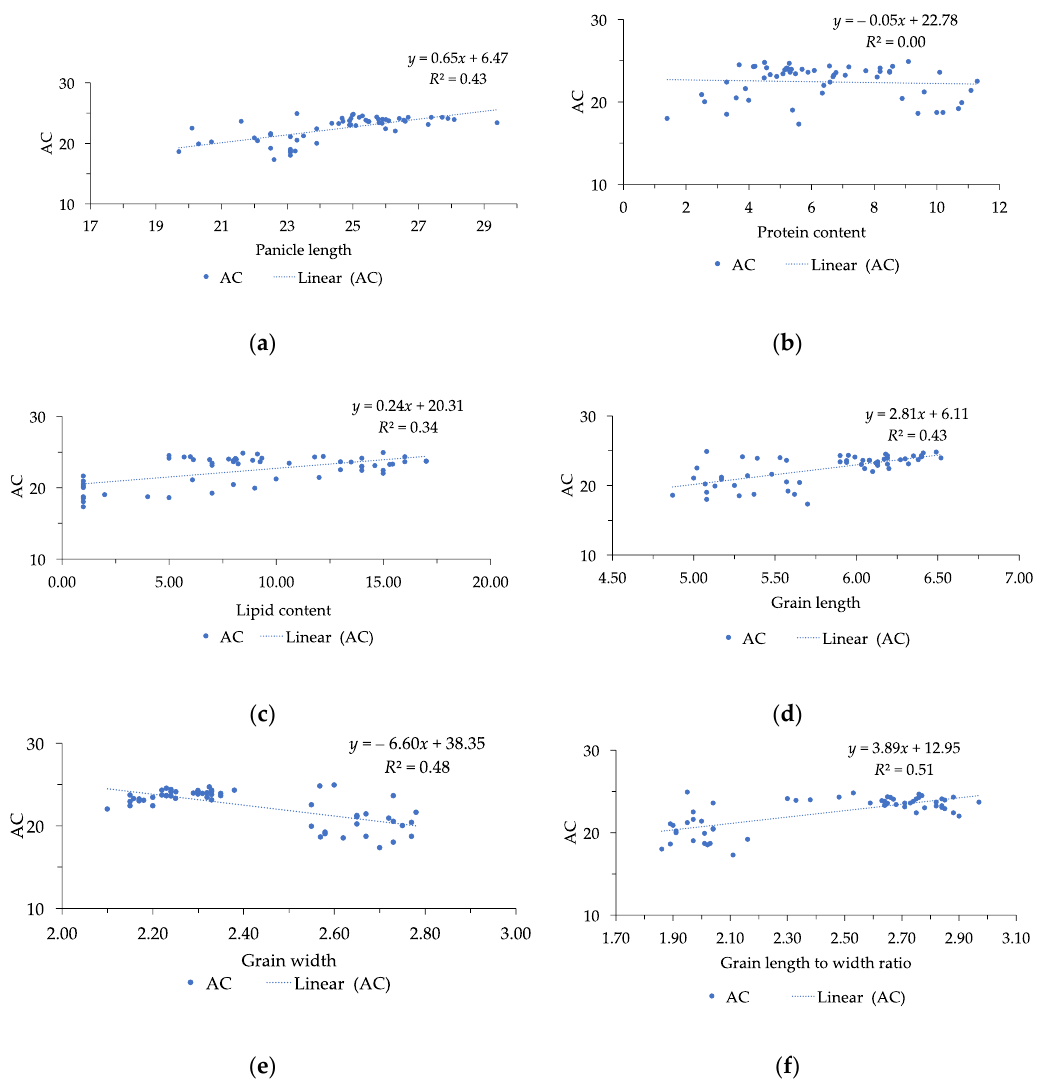
Figure 2. Relationship between amylose content and ( a ) panicle length, ( b ) protein content, ( c ) lipid content, ( d ) grain length, ( e ) grain width, ( f ) grain length to width ratio.